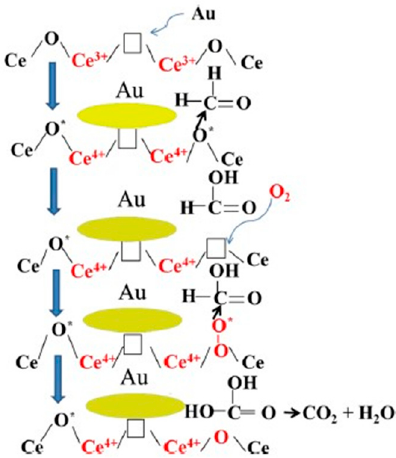
Figure 2. Lattice ceria oxygens of Au / CeO 2 catalyst involved in catalytic oxidation of formaldehyde. Reprinted (adapted) from [80], Copyright 2014, American Chemical Society.